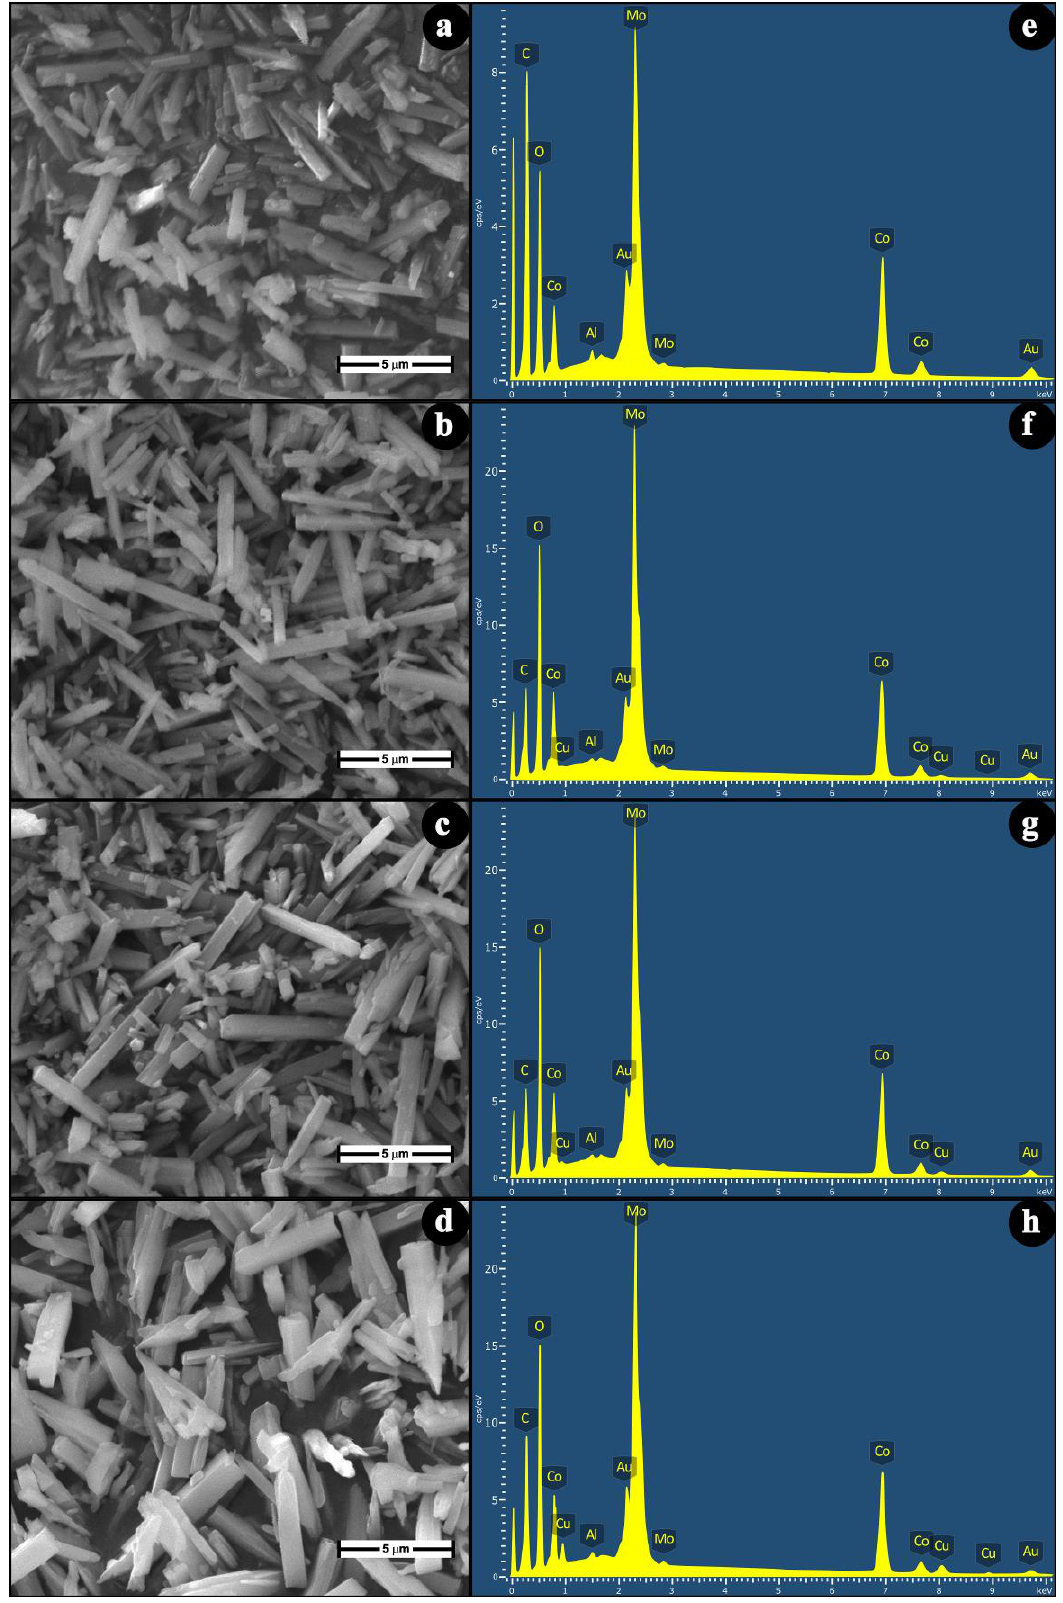
Figure 4. SEM and Energy Dispersive Spectroscopy (EDS) images for ( a , e ) pure CoMoO 4 · 1.03H 2 O and Co 1 − x Cu x MoO 4 · nH 2 O with x equals to ( b , f ) 0.03 ( c , g ) 0.06 ( d , h ) 0.12.